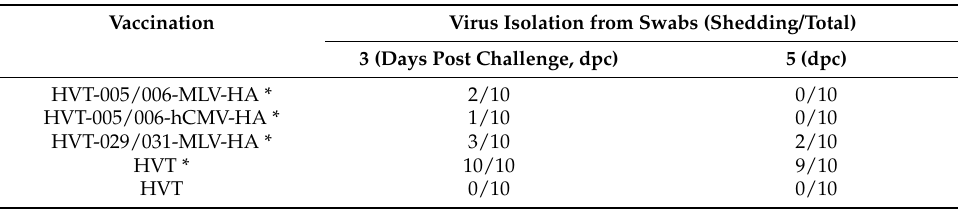
Table 2. Virus detection in swabs of vaccinated and mock-vaccinated chickens challenged with H9N2 at different time points.